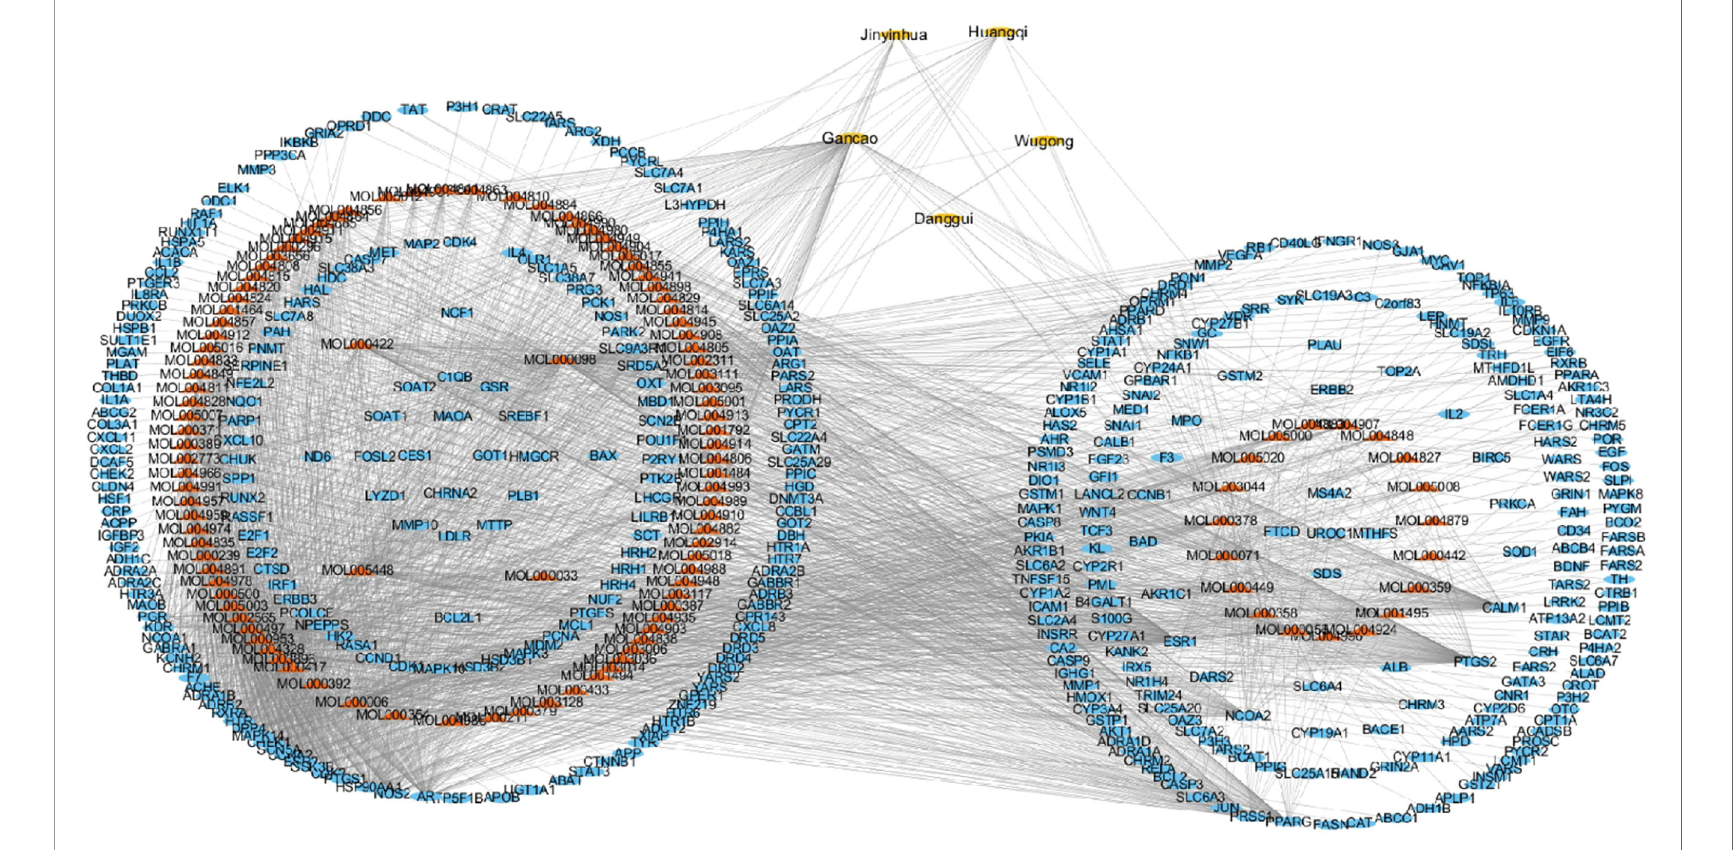
FIGURE 4 | Ingredient-target network of